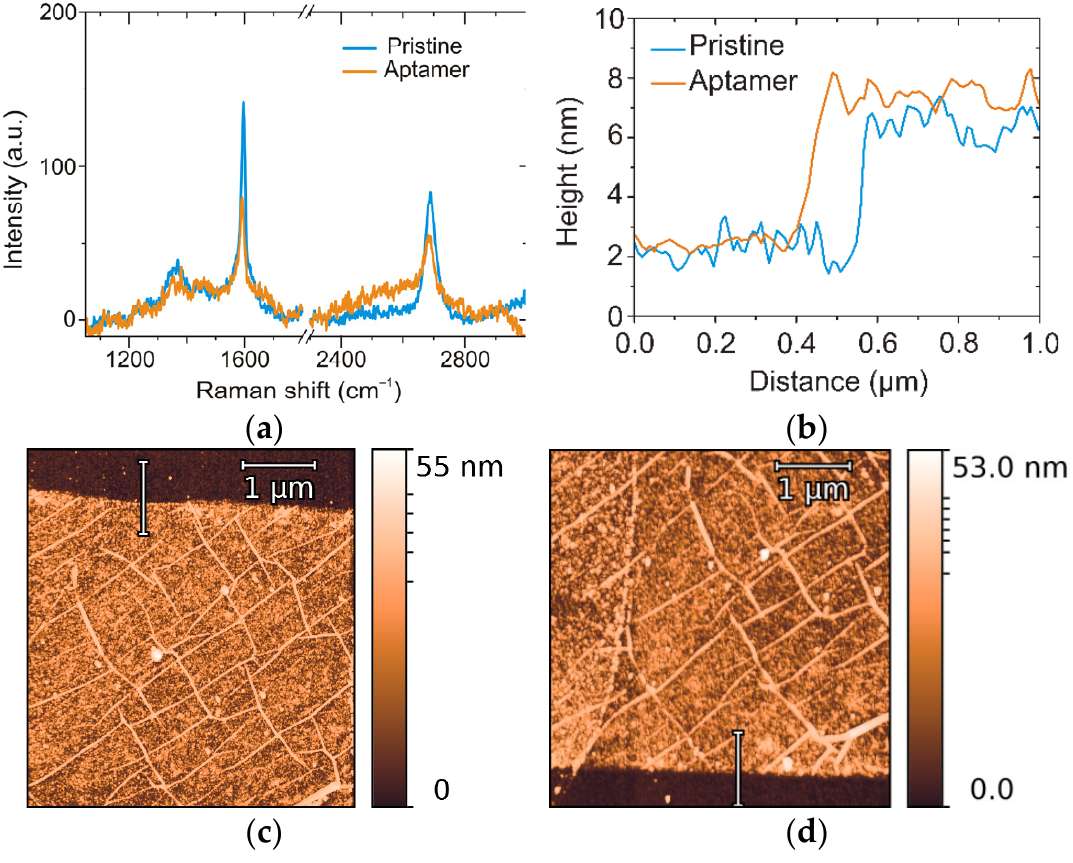
Figure 2. Characterization of the sensor surface after photochemical attachment of the aptamer. Raman shifts of graphene before and after azide-aptamer immobilization ( a ). Cross section of AFM image of graphene channel before and after aptamer binding ( b ). AFM images for pristine graphene channel ( c ), and channel after azide-modified aptamer attachment ( d ). Lines on ( c , d ) show the cross-section positions for ( b ).